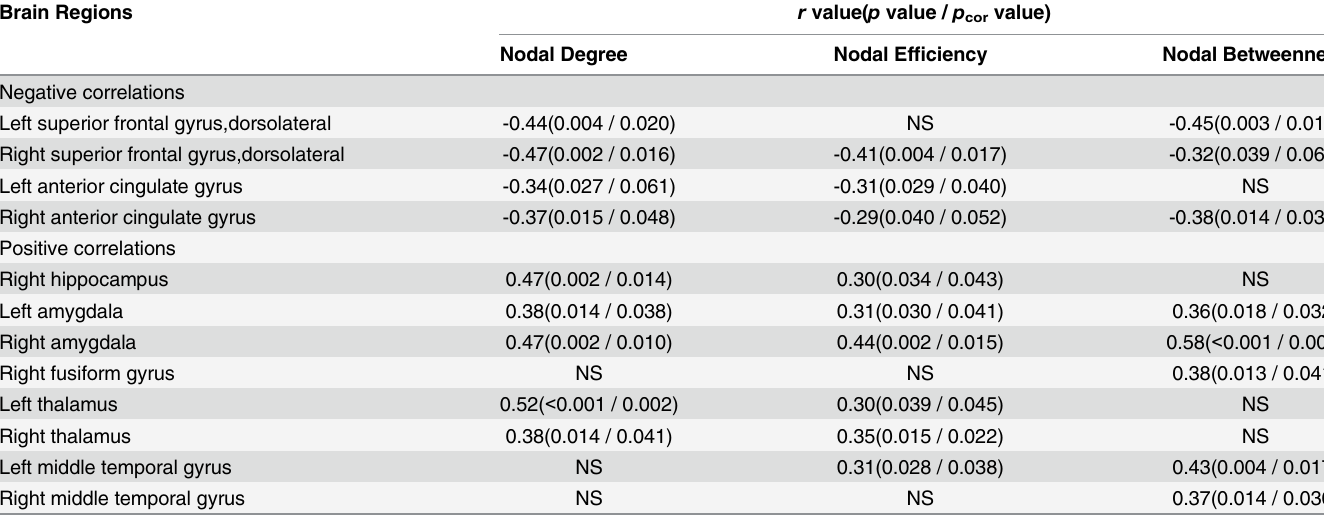
Table 3. Pearson correlation coefficients between regional nodal properties and HAMD scores of MDD patients (cost =